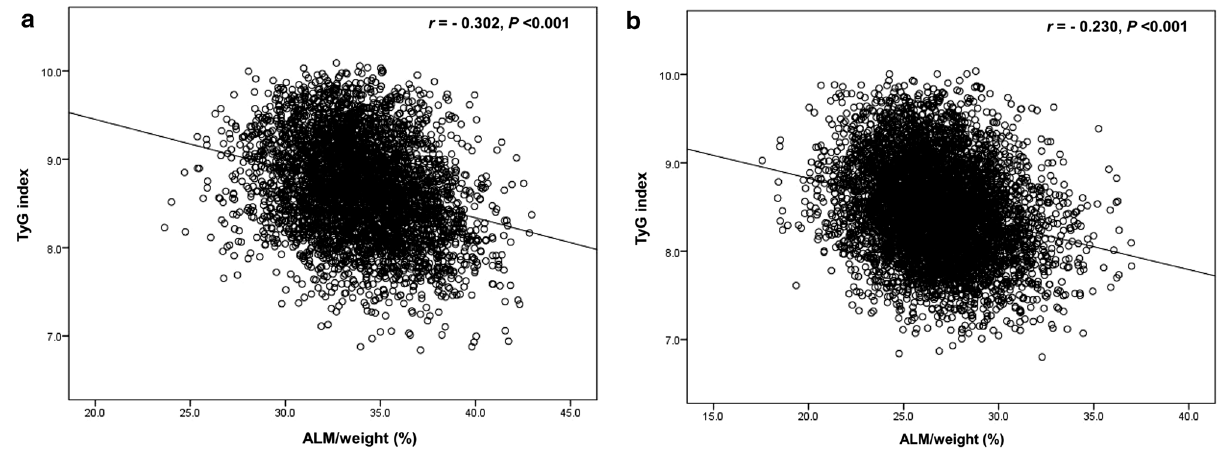
Figure 3. Scatter plot of the TyG index with ALM/weight in ( a ) men and ( b ) women. ALM appendicular lean mass; TyG index triglyceride-glucose index.